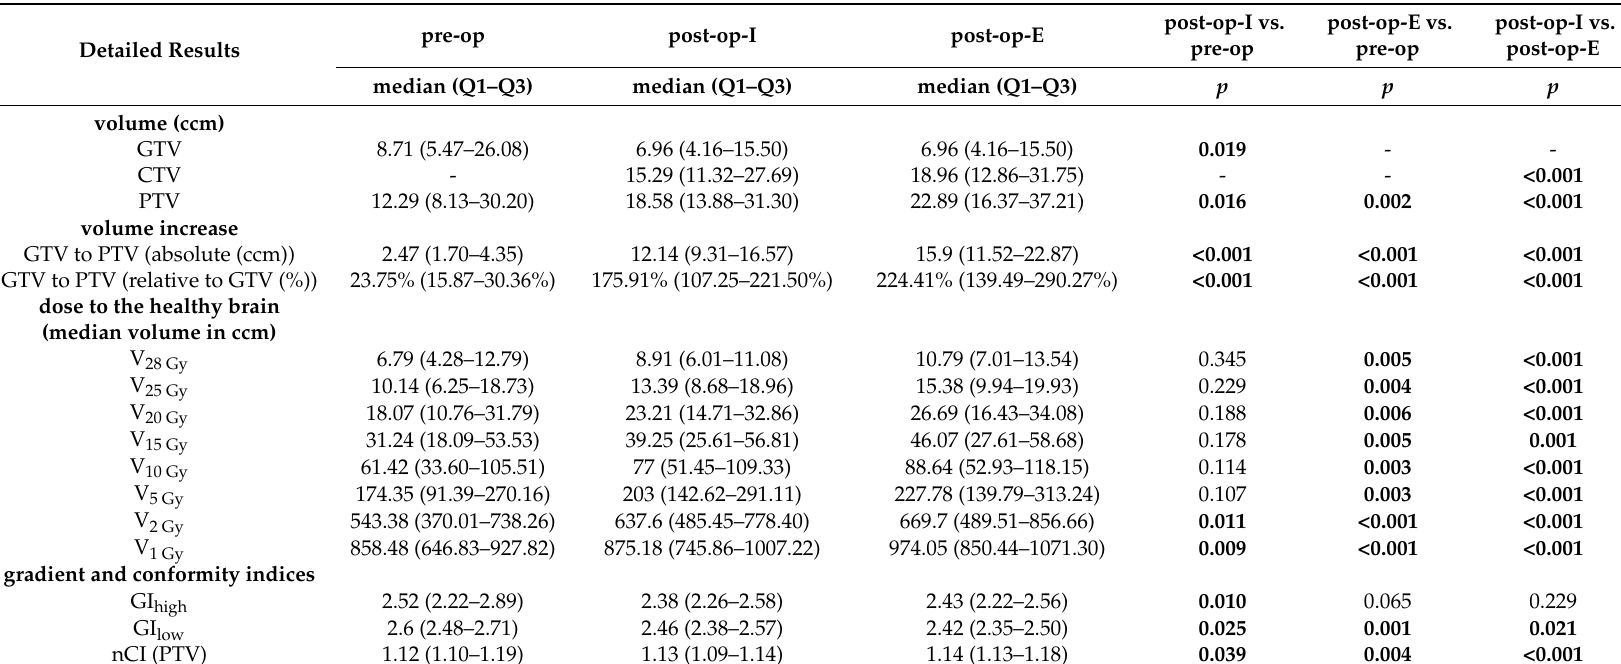
Table 4. Detailed quantitative results of volumetric and dosimetric comparison between the pre-operative (pre-op) and two post-operative settings, targeting the involved field (cavity + 3mm, post-op-I) and extended field including the complete surgical tract (post-op-E). To the right, p-values for pair-wise comparison (Wilcoxon signed rank test for paired data) are displayed. Significant p-values are indicated in bold